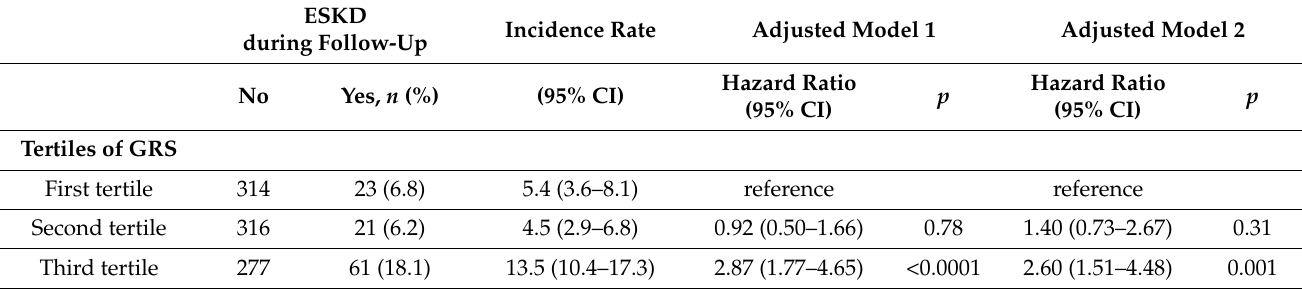
Table 3. Risks of ESKD during follow-up by redox genetic risk score, considered as continuous var- iable, in each individual cohort.